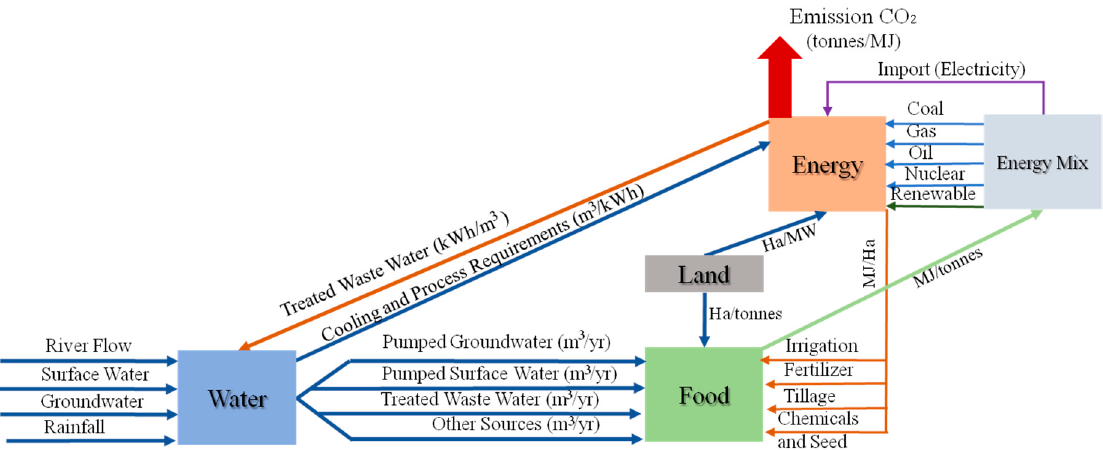
Figure 2. Identified resource interactions of the system for the developed analytical